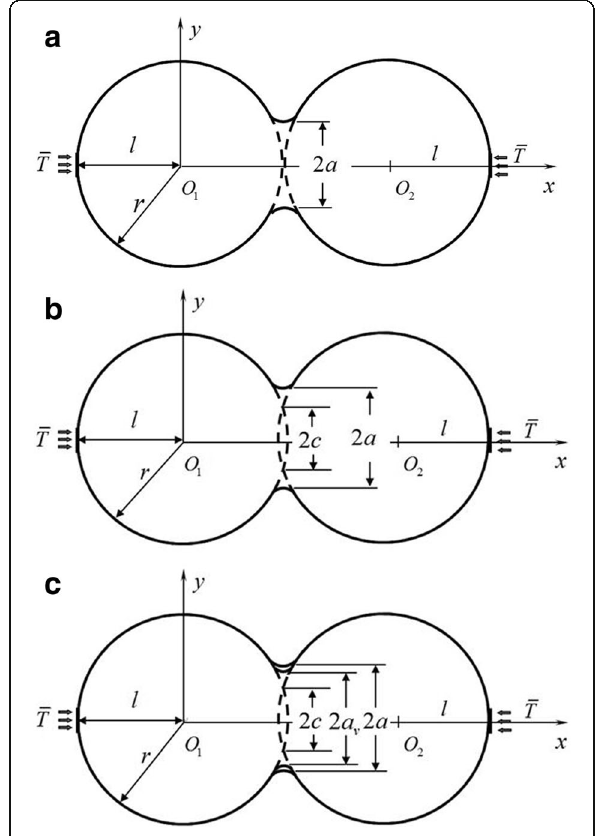
Fig. 1 Double equal-sized spherical models (Wang 1990). a Surface diffusion. b Volume diffusion. c Simultaneous surface and volume